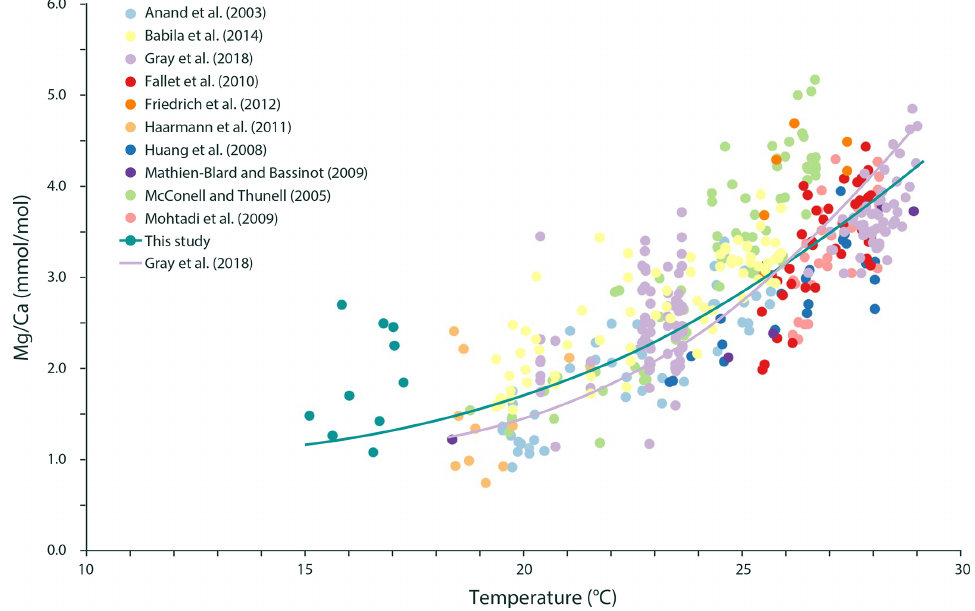
Figure 6. The relationship between Mg / Ca in G. ruber albus and temperature during calcification can be described using the following exponential equation for a temperature range from 15.1 to 29.1 ◦ C: Mg / Ca = 0 . 278 × exp(0 . 093 × T